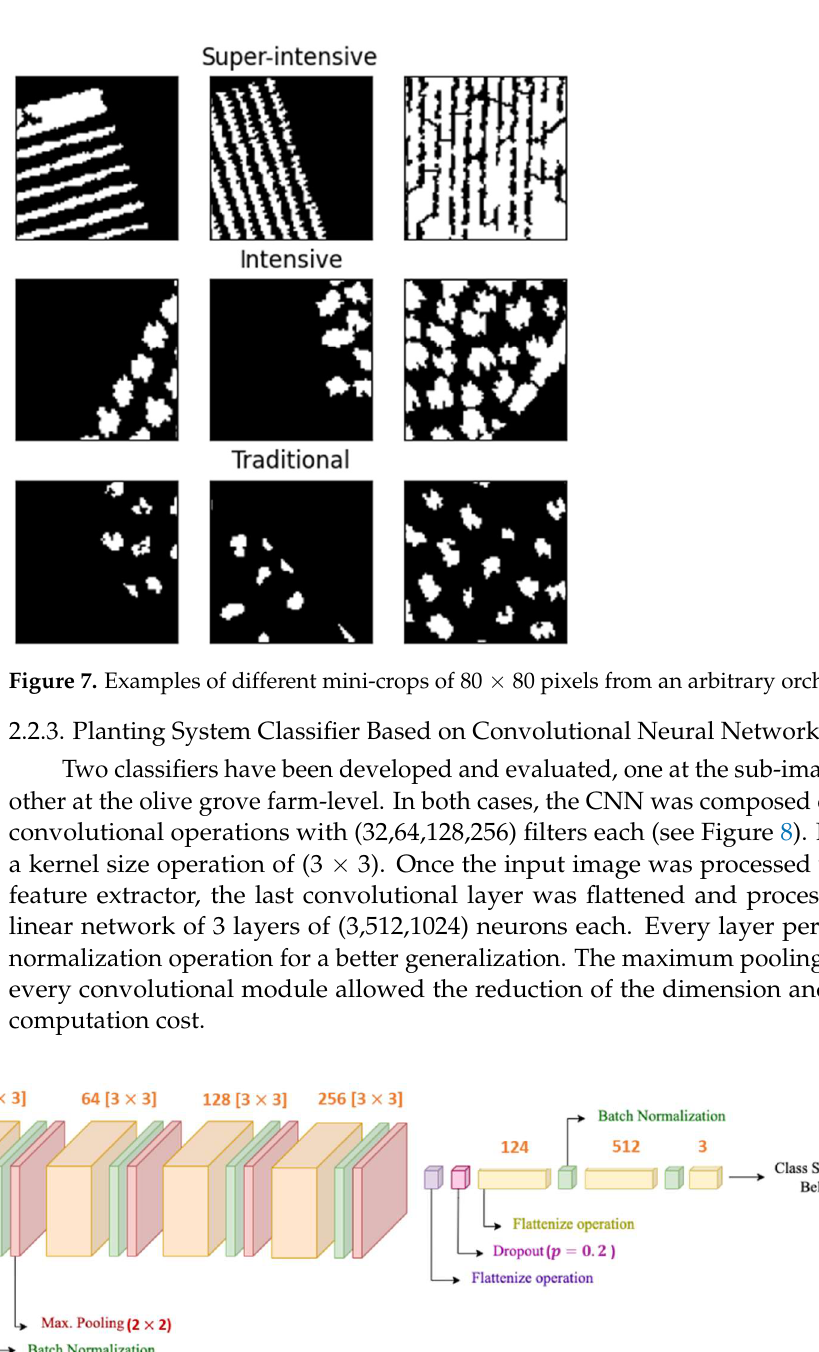
Figure 7. Examples of different mini-crops of 80 × 80 pixels from an arbitrary orchard.